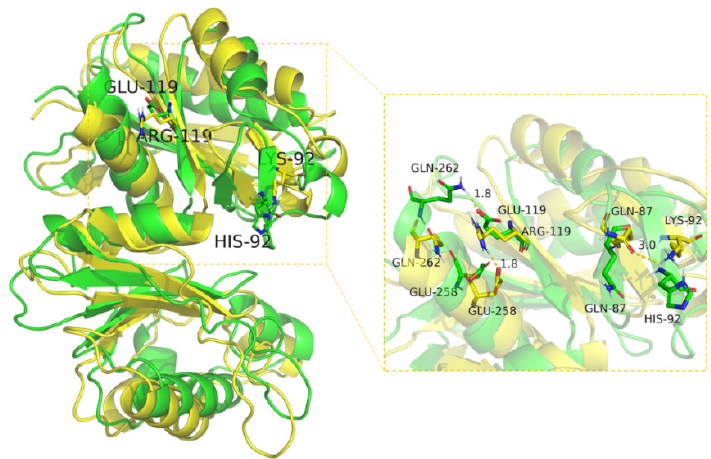
Figure 8. Structural comparison of WT and H92K/E119R at different temperatures after 100 ns MD. The area with larger local RMSD is marked. ( a ) Structural contrast of H92K/E119R at 300 K and 360 K ( b ) Structural contrast of WT at 300 K and 360 K.